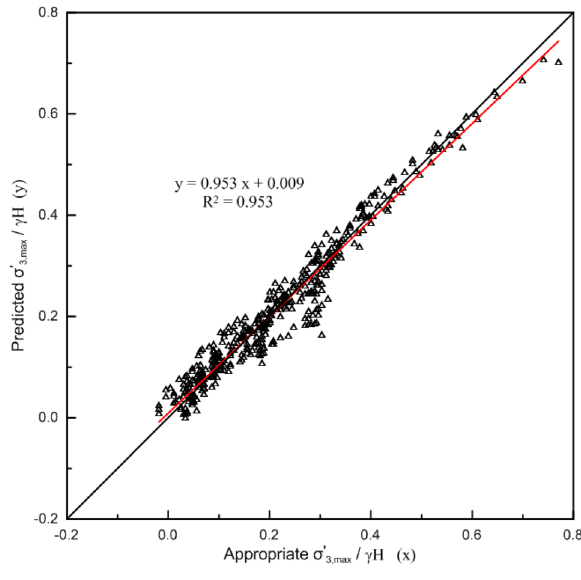
σ ′ 3,max γ H values and predicted values from Eq.